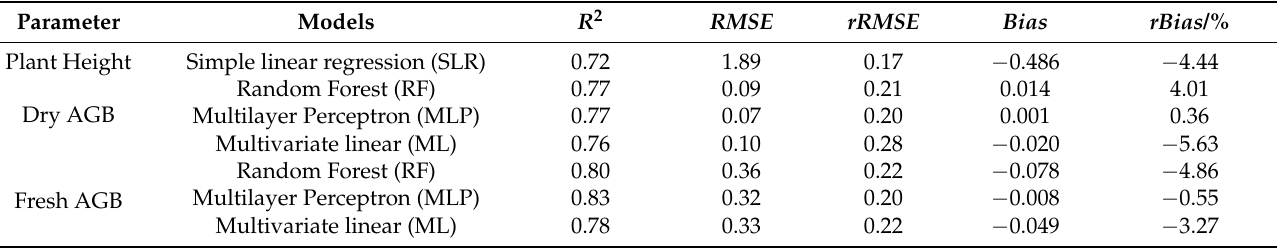
Figure 6. Prediction of dry AGB using the random forest (RF) regression model ( a ) and the importance of all predictor variables ( b ). Prediction of fresh AGB using the RF regression model ( c ) and the importance of all predictor variables ( d ). Table 4. Comparative results for the test dataset of different estimation